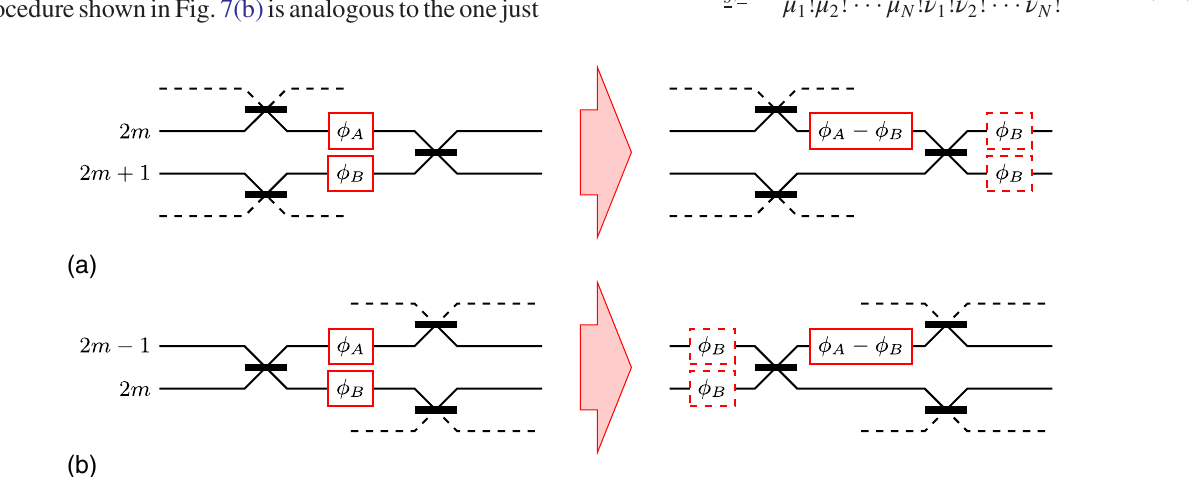
FIG. 7. Procedures for reducing the number of phase shifters in the device of Fig. 1(a), without changing its output distribution when Fock states are injected at the inputs. The procedures allow us to set to zero the phase term placed on one of the internal arms, by modifying the phase on the upper adjacent arm and by adding phase shifts at the inputs or at the outputs. Panels (a) and (b) hold, respectively, for odd and even